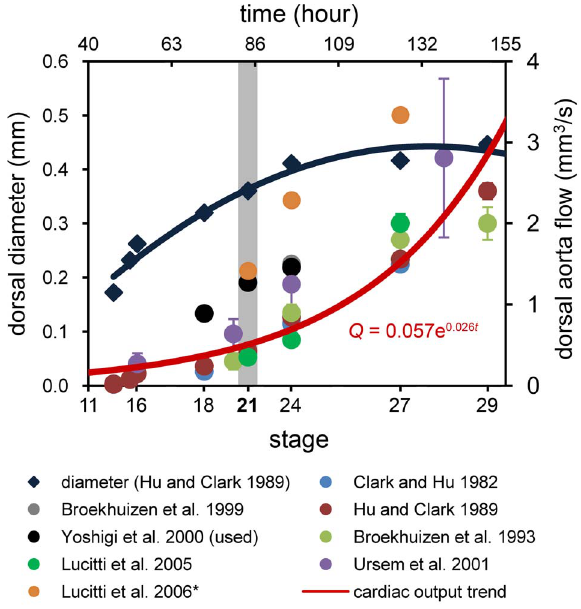
Figure 7. Cardiac output increases exponentially with de- velopmental stage while dorsal aorta diameter lags. The rate of change can vary from embryo to embryo and may be related to the multiple AA configurations observed at stage 21 (highlighted in gray). * Lucitti et al. [60] reported velocity data only, which we converted to flow rate using dorsal aorta diameter data from Hu and Clark [52]. Equation of the exponential trend is given in the lower right corner, where Q is the flow rate and t is time, in hours.